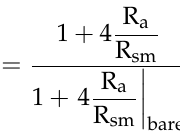
θ in each solid substrate. ave